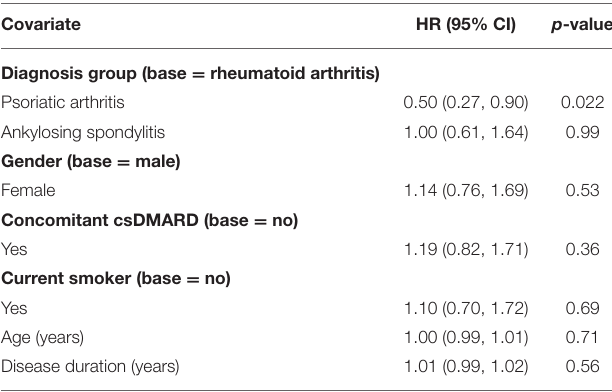
TABLE 4 | Multivariable conditional risk set cox regression model (for multiple events) for predictors of b/tsDMARD failure. Covariate HR (95% CI) p -value Diagnosis group (base = rheumatoid